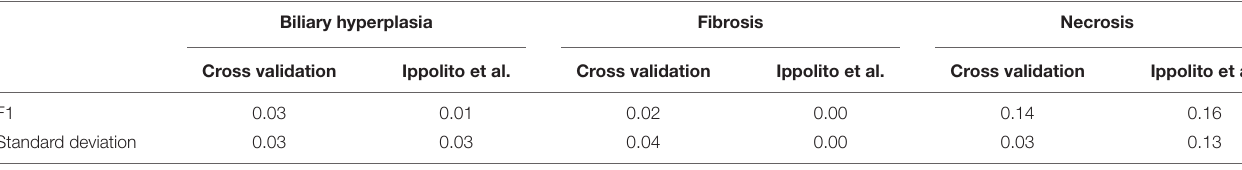
TABLE 8 | Performance of Y-shuffled DNN models.